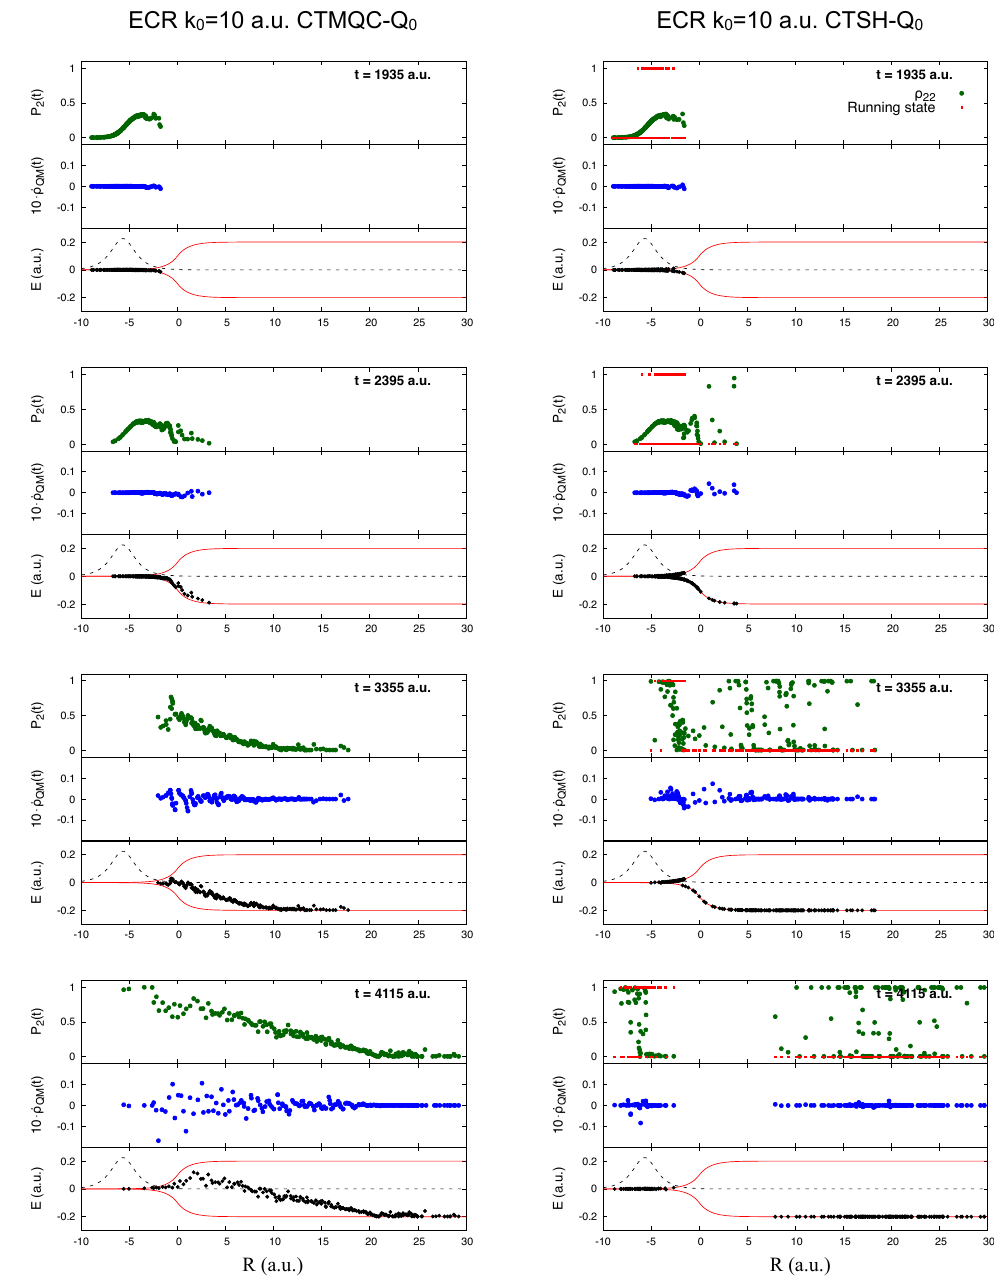
Figure 7. Same as in Figure 6 but using the original definition of the quantum momemtum. The electronic populations of CTSH with the original quantum momentum definition Equation (22) show a strikingly different behavior than that of CTMQC, with many contin- uing to rise after the first transfer event, before leveling off (see the right panels of Figure 7 for CTSH results to be compared to the CTMQC results just described). As in CTMQC with this definition, there is violation of the zero net population transfer condition in the transmitted wavepacket, but the populations behave very differently: each of the transmit- ted and reflected wavepackets have populations spanning both upper and lower surfaces in CTSH, and the unphysical growth of the trajectory-averaged populations in Figure 5 comes primarily with trajectories associated with the transmitted part of the wavepacket. In contrast, in CTMQC, there is a linear shape to the population going from more on the upper surface on the reflected side to more on the lower surface on the transmitted packet. Interestingly, the CTSH fraction of trajectories is similar to that with the modified